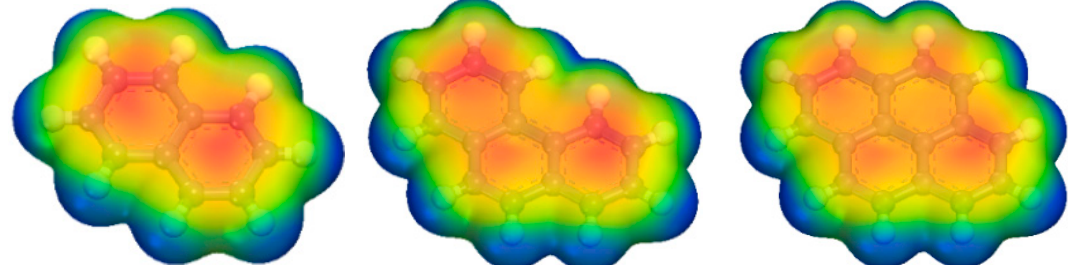
Figure 7. Electrostatic potential and charge density distribution results of Nap, Phe and Pyr. The electrostatic potential distribution ranged from − 0.03 to 0.03, with the blue portion representing the positive potential and the red portion representing the negative potential.